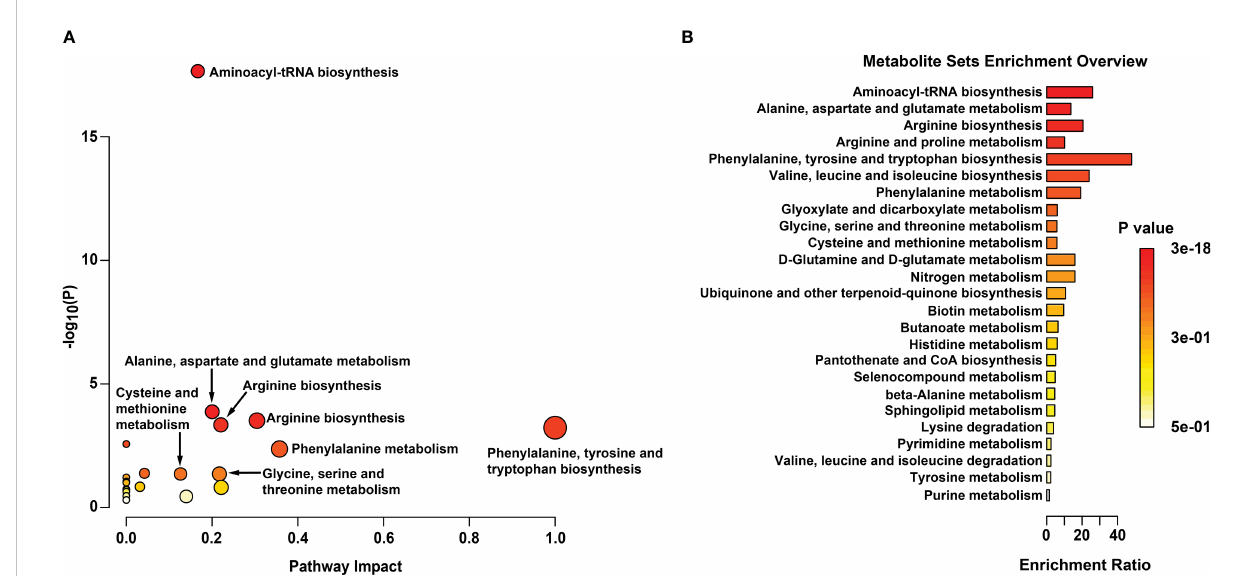
FIGURE 7 Metabolic pathway analysis (A) and enrichment analysis (B) of signi fi cant differential amino acids between HUVECs and HemECs by targeted metabolic analysis. In (A) , each related metabolic pathway is shown as a circle, in which the size and color are based on the pathway impact value and the P value,